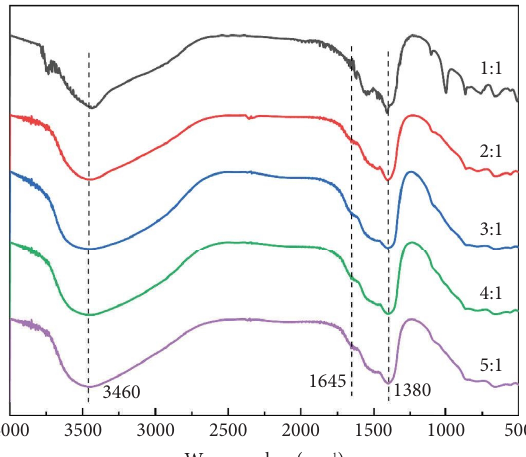
Figure 3: FT-IR spectra of diferent load ratios of KF/Mg-Ca-Al HTLCs (Ca/Mg � 1:1, hydrothermal time: 24h, and Mg-Ca-Al HTLCs calcined at 773K).